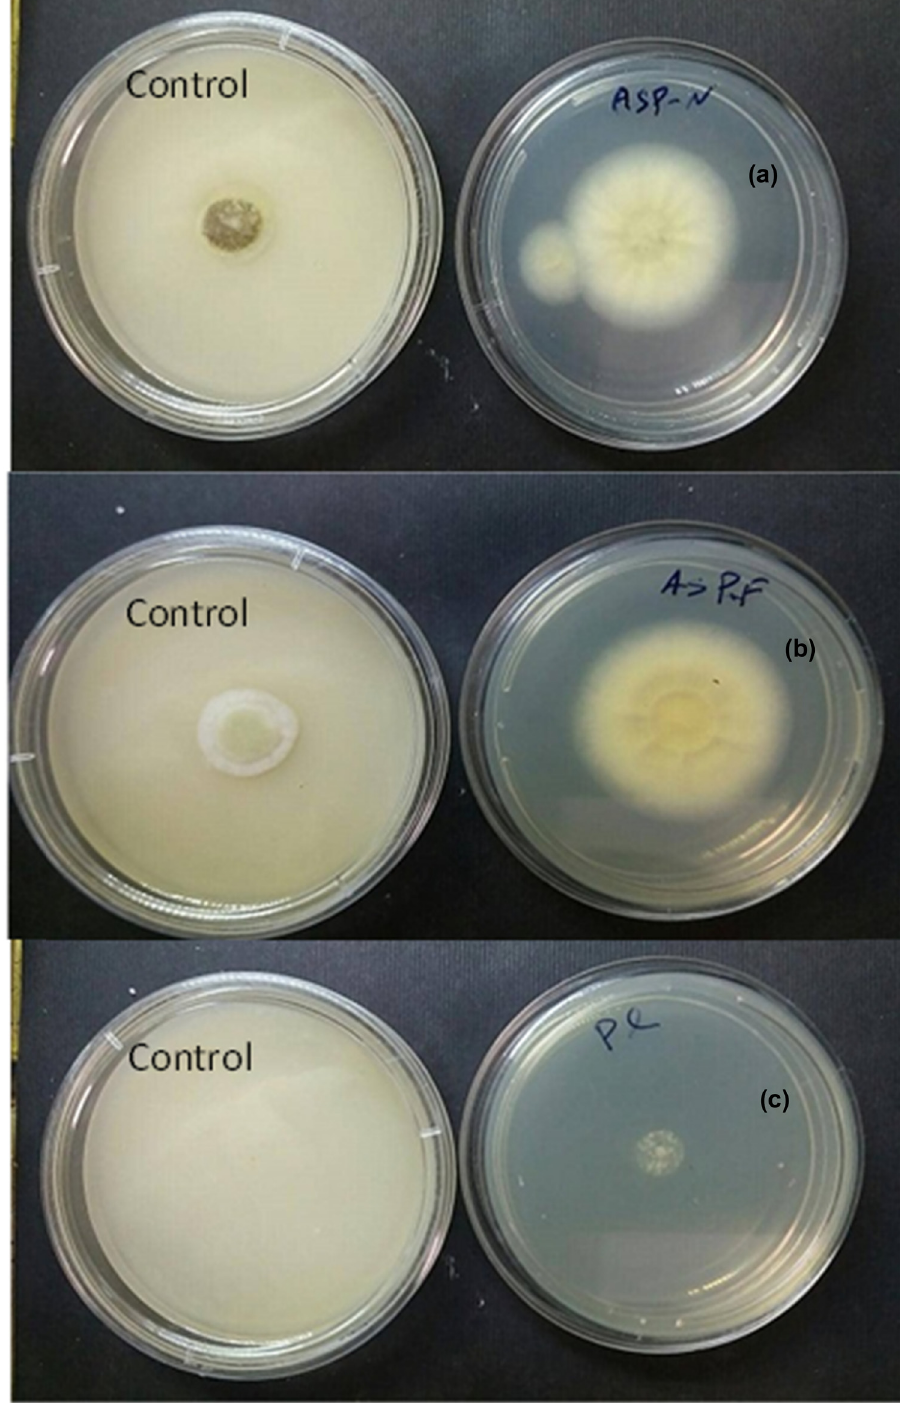
Figure 6: Mycelia growth of A. niger ( a ) , A. fl avus ( b ) , and Penicillium aculeatum ( c ) in the plates containing fabricated ZnO NPs as compared to the control plates ( without ZnO NPs ) after 4 days of incubation at